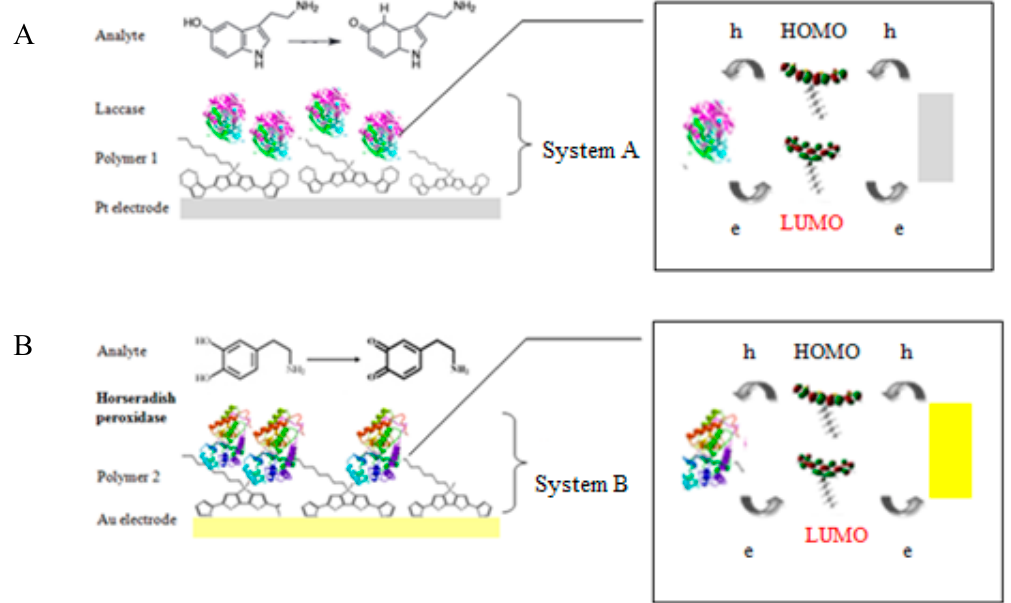
Figure 3. Scheme of ( A ) measuring system A: Pt-E / bisEDOTDTSi / Lac and ( B ) system B: Au-E / bisSeDTSi / Pox. HOMO: highest occupied molecular orbital, LUMO: lowest unoccupied molecular orbital.